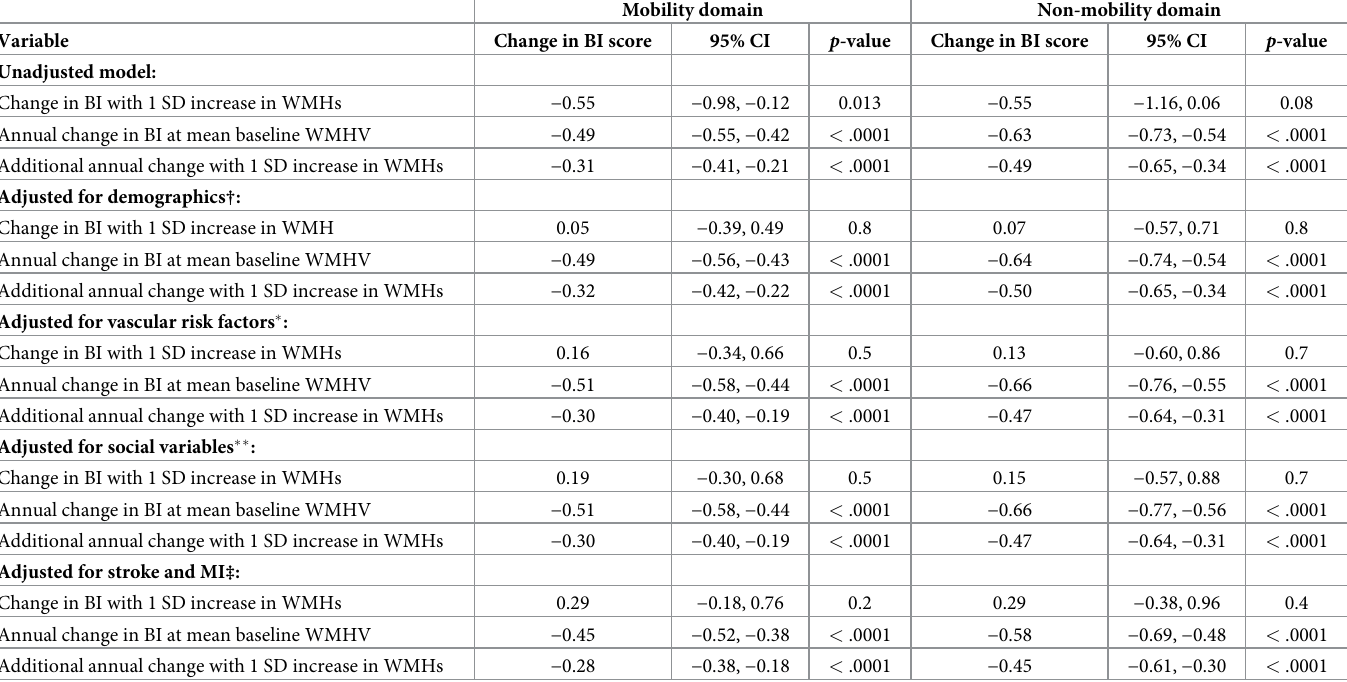
Table 3. Unadjusted and adjusted models of the association between standardized whole brain white matter hyperintensity volume (WMHV/TCV) and functional status, stratified by mobility versus non-mobility